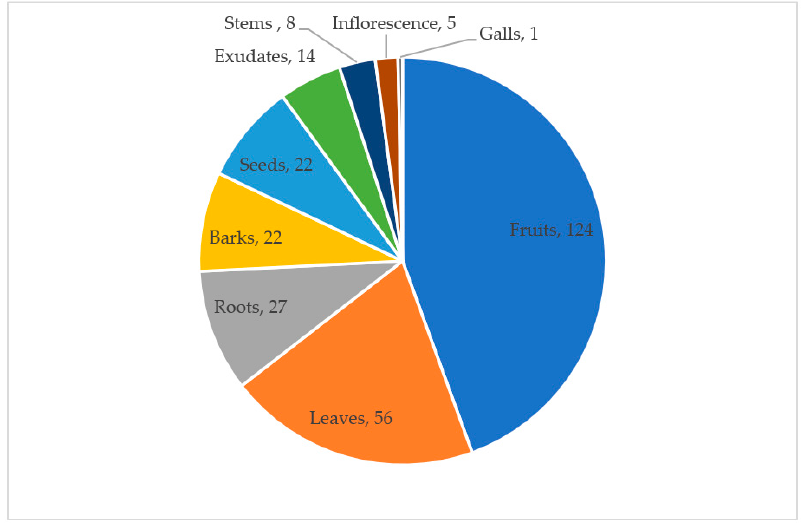
Figure 4. Number of species by parts of plants eaten (numbers represent reports per category).